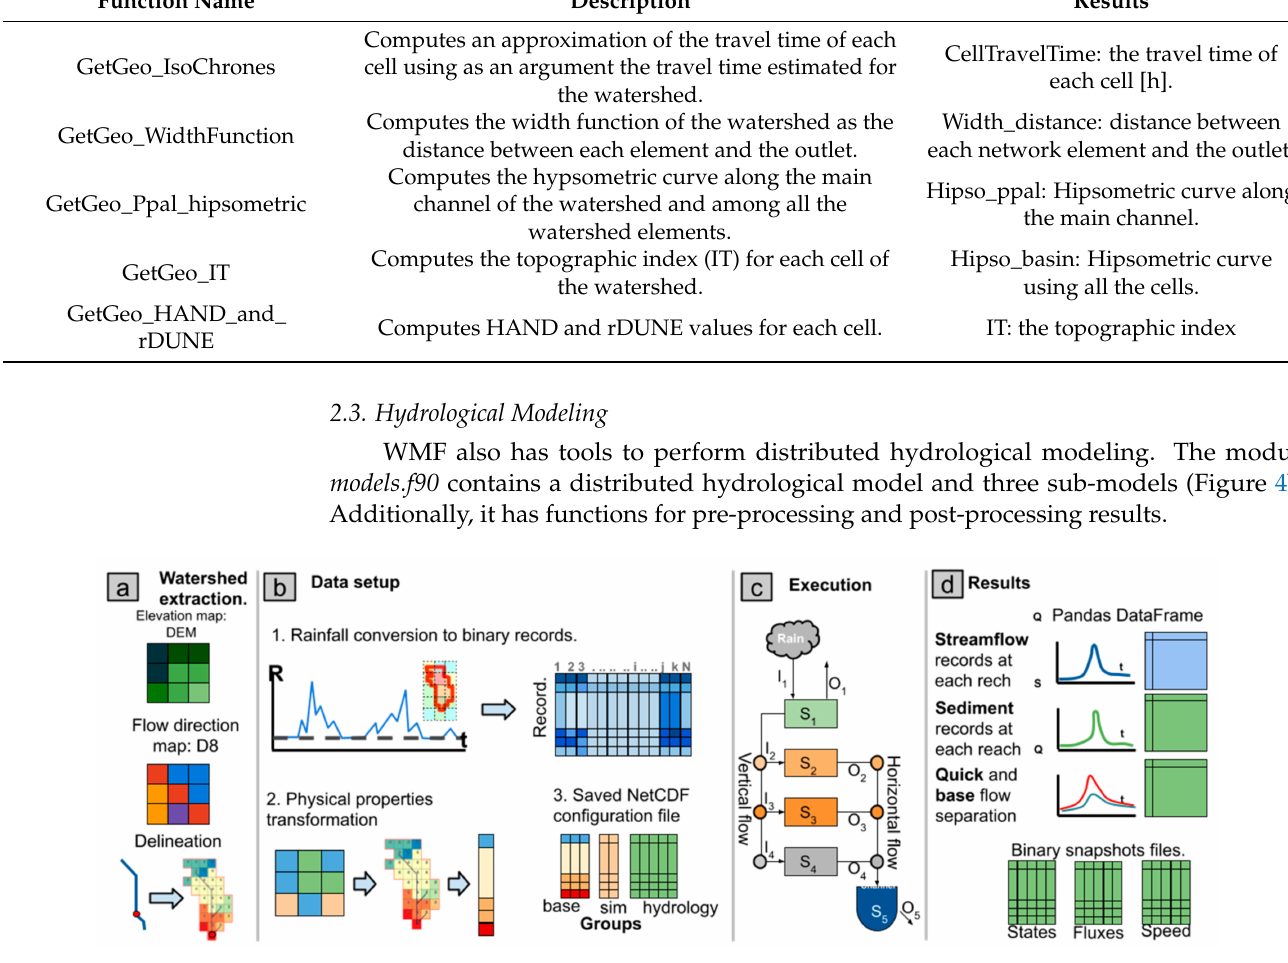
Figure 4. WMF hydrological model architecture. ( a ) Watershed extraction from a DEM and a DIR map. ( b ) Data pre-processing to obtain binary rainfall data (top blue matrix) and the netCDF file that